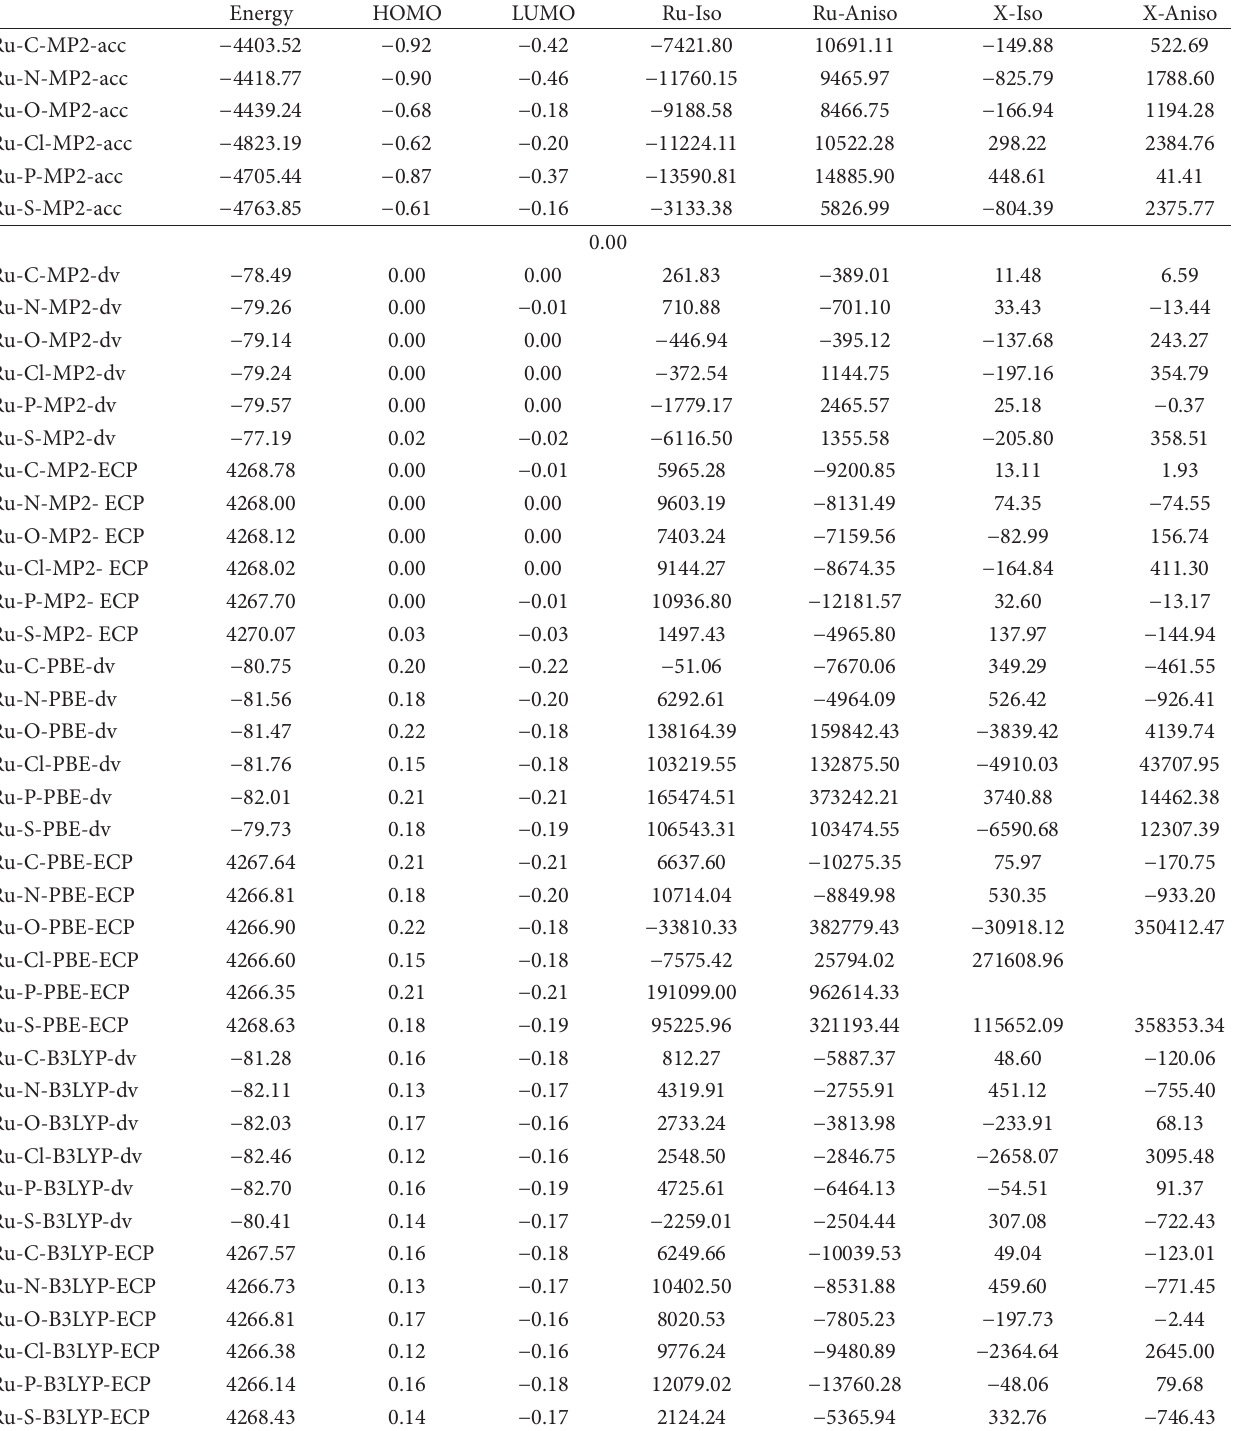
Table 5: The energy, shielding tensors, and 𝐽 -coupling values using MP2/acc method and the differences using other computational methods (the energy values in